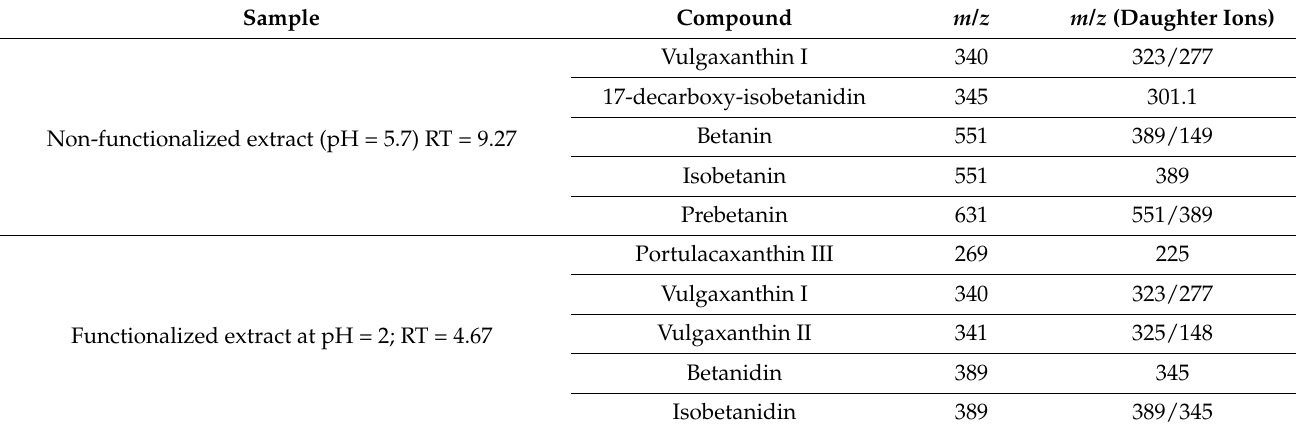
Table 3. The mass spectral data of betalains from peels of red